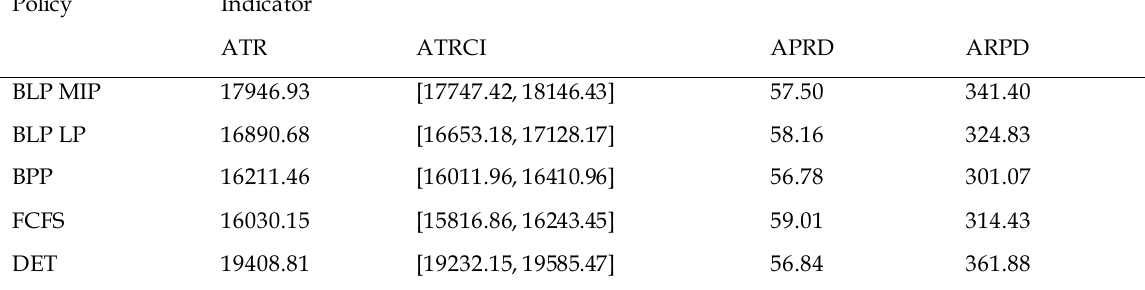
Table 1. Results of different